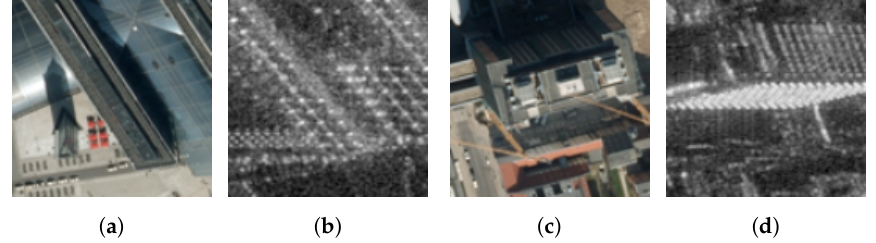
Figure 1. An illustrative example of the vast differences between synthetic apature radar (SAR) and optical remote sensing imagery of the same scene. The corresponding image patch-pairs ( a – d ) would prove challenging to determine correspondence, even for experts in the